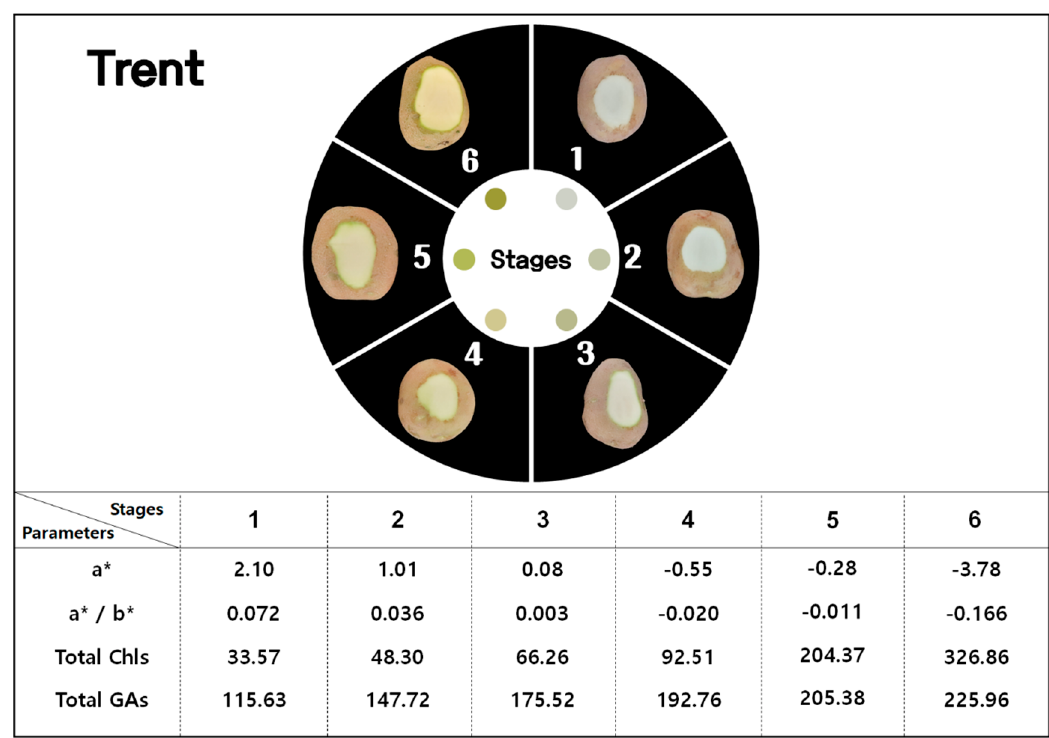
Figure 3. Index for the estimation of total glycoalkaloids (Gas) of ‘Atlantic’ potato cultivar at six greening stages based on color values and chlorophyll (Chl) content.